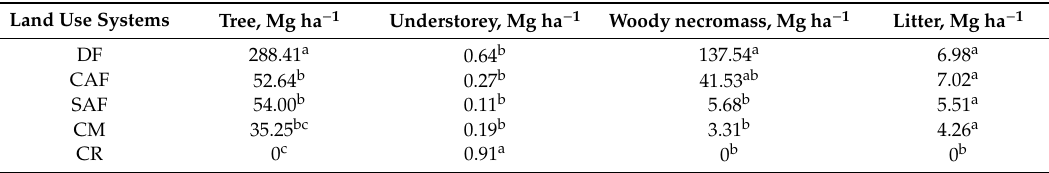
Table 3. Tree biomass, understorey biomass, necromass, and litter in cacao-based agroforestry systems (DF = Degraded forest; CAF = Cacao complex agroforestry; SAF = Cacao simple agroforestry; CM = Cacao monoculture; CR = Annual crops).